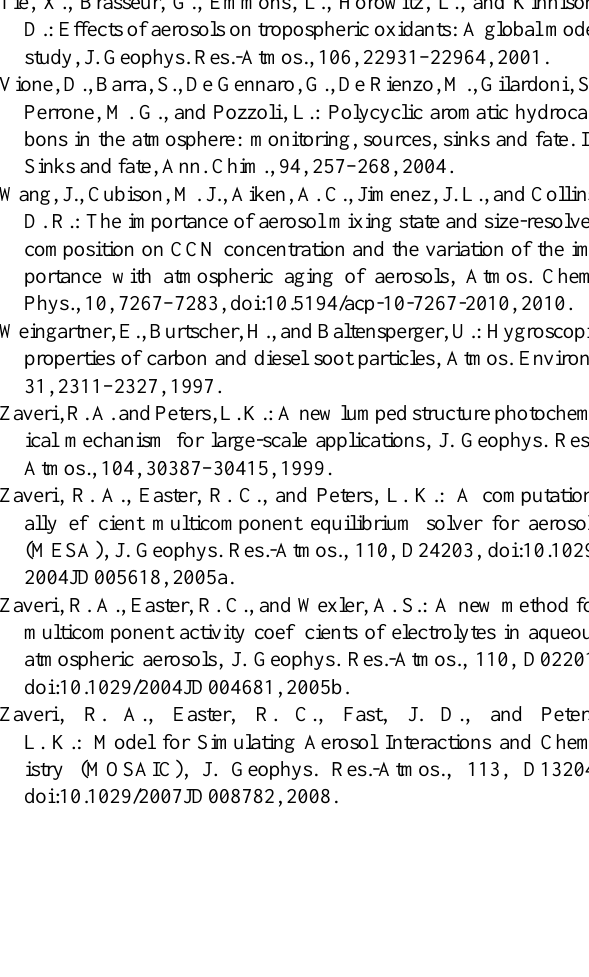
Tabor, K., Gutzwiller, L., and Rossi, M. J.: Heterogeneous chemical kinetics of NO 2 on amorphous carbon at ambient temperature,